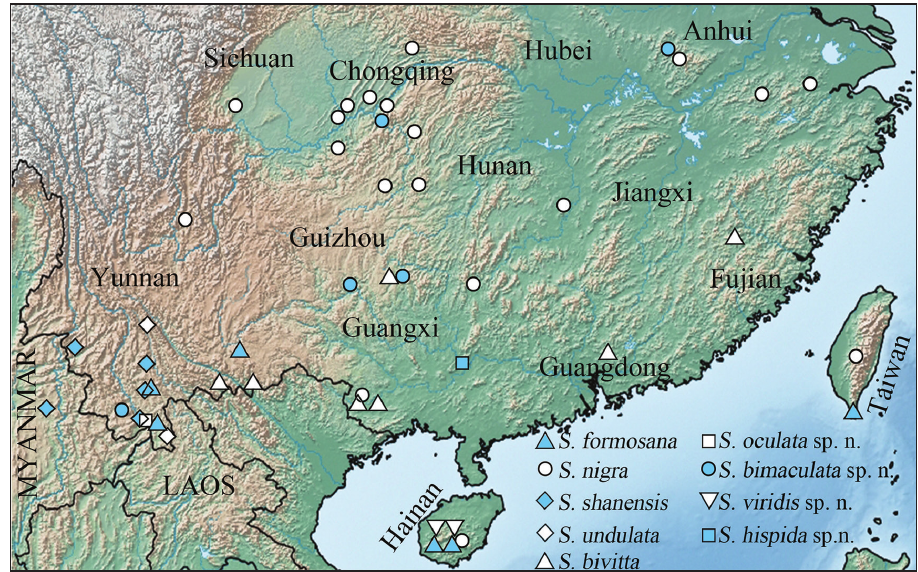
Figure 1. Known occurrences of Sorineuchora in China and